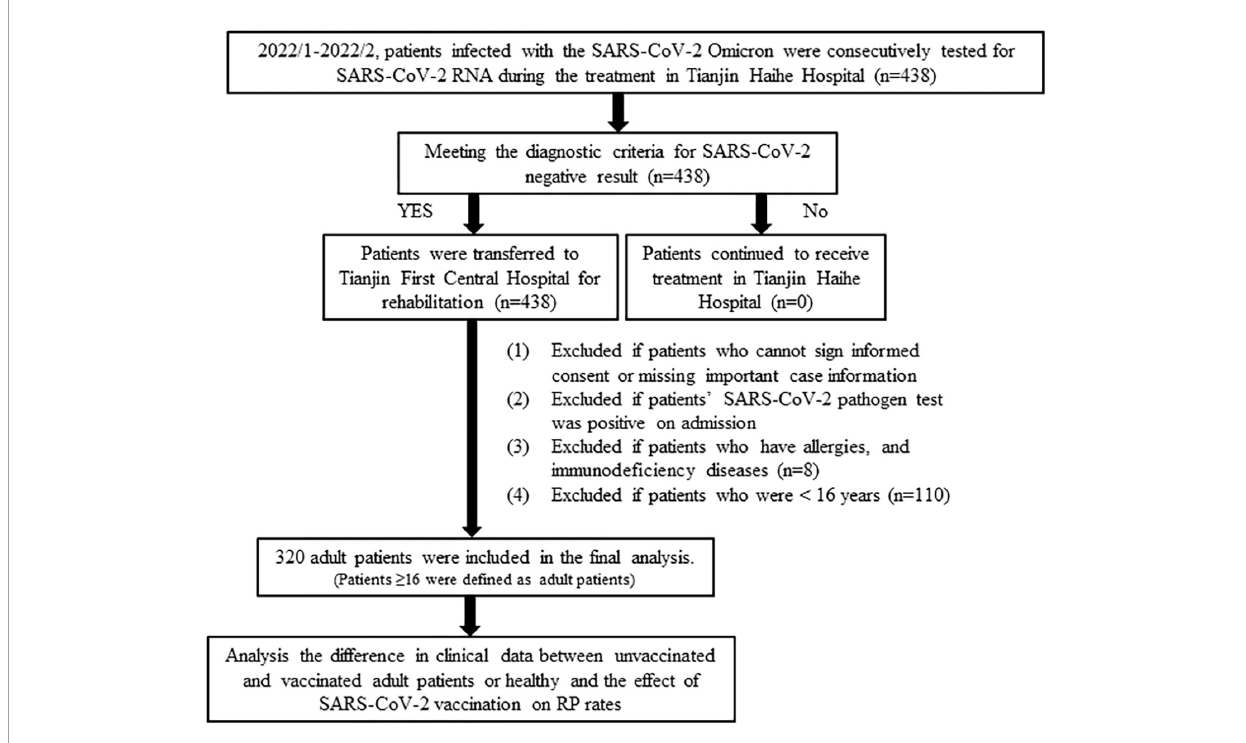
FIGURE1 The flow chart of the critical of cases inclusion or exclusion.